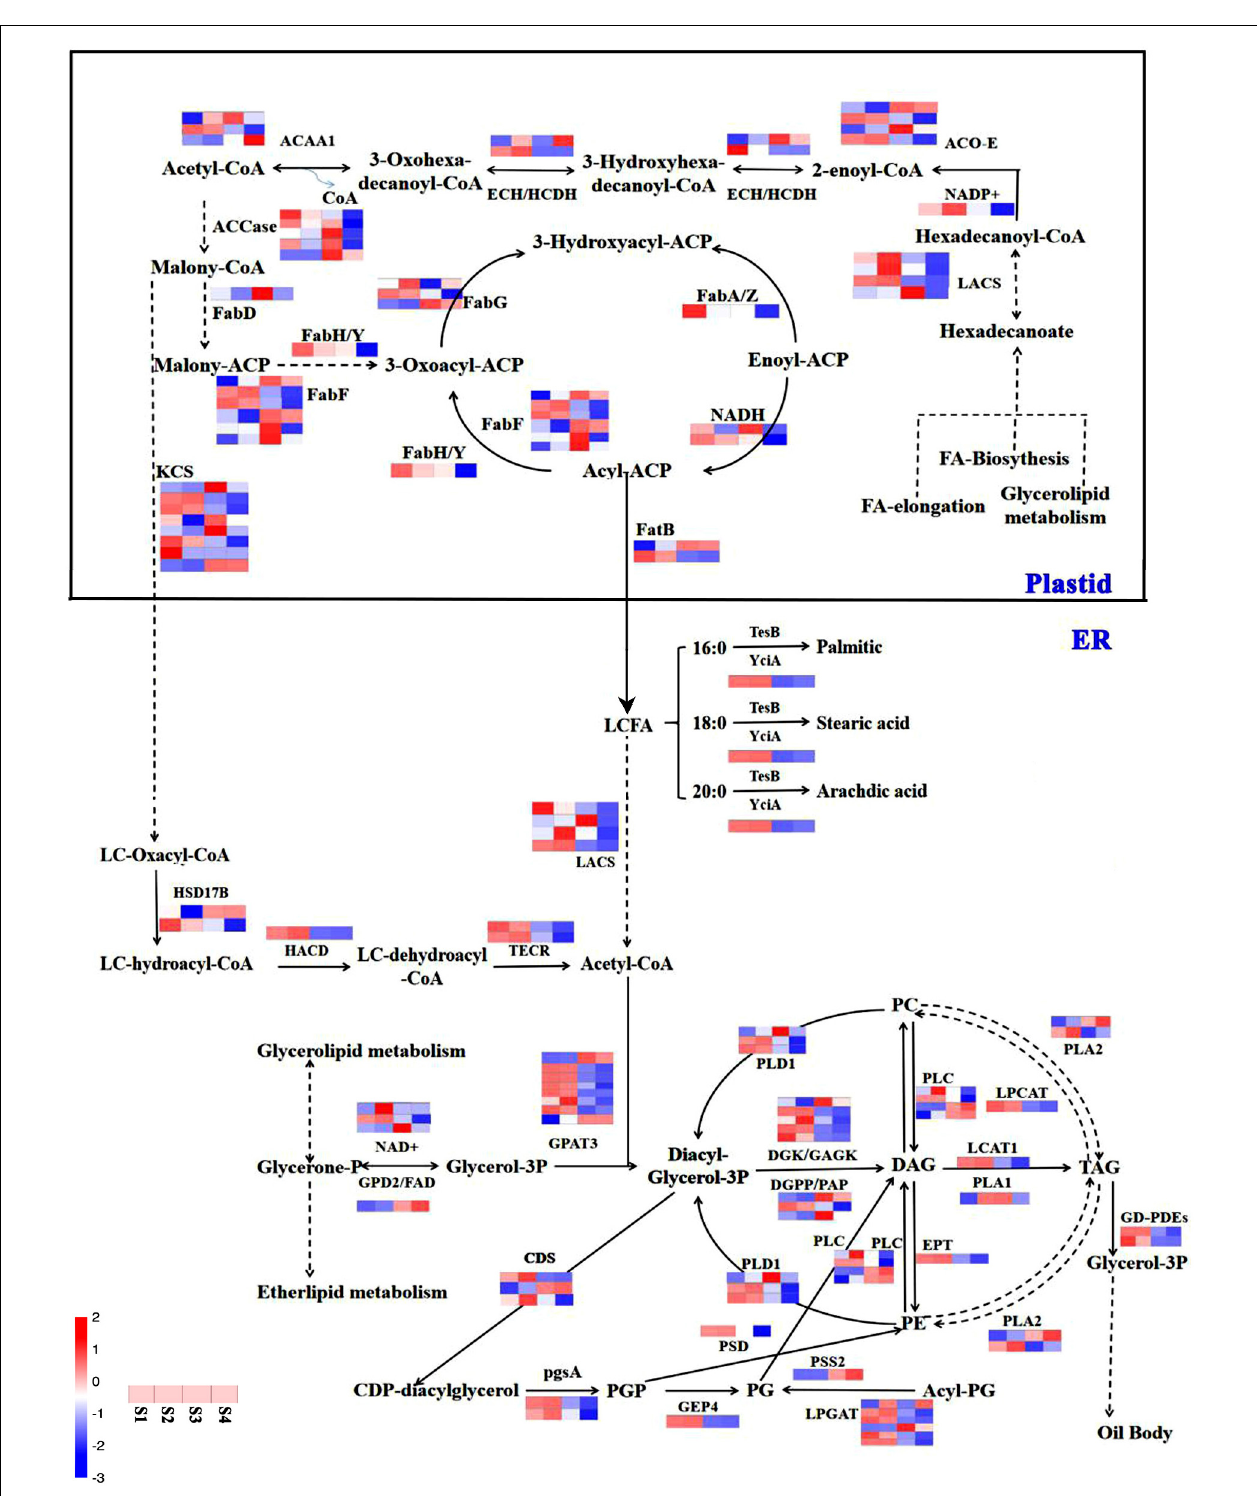
FIGURE 9 | Relation network of miRNAs and target genes with lipid and fatty acid biosynthesis in sesame seeds. The blue color represents the down-regulated gene expression pattern, while the red color represents the up-regulated gene expression pattern.